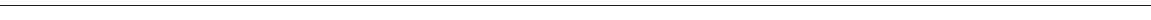
FIGURE 5 | neuron-specific NF-L mRNA cannot be adequately accounted for by a non-specific effect of brain damage, neuron cell loss, or loss of neurons with neurofibrillary degeneration (McLachlan et al., 1988; Lukiw et al., 2018). The AD group ( N = 3) had a mean age of 76.1 ± 11.4 years and a mean post mortem (PMI; death to brain-freezing period) of ∼ 3.4h and the control group ( N = 3) had a mean age of 75.5 ± 12.7 years and a mean PMI of ∼ 3.5h; all brain samples were from female donors; there was no significant difference in the mean age, gender, PMI, or yield of total RNA between the AD and control groups. Total RNA was extracted and probed for α -tubulin, VAMP, synaptophysin, synapsin, the neurofilament light and medium neurofilaments, and quantified based on unchanging β -actin control levels in the same sample using methods explained in detail in previously published study from our laboratories (McLachlan et al., 1988; Lukiw et al., 2008, 2018); deficits in synapse-relevant gene expression were consistently found to be NF-L < synapsin < synaptophysin < VAMP; these observations are also consistent with synaptic signaling deficits in AD brain compared to three unchanging biomarkers: β -actin, α -tubulin, and the NF-M chain protein; * p < 0.05; ** p < 0.01 (ANOVA). (B) Down-regulation of mRNAs coding for vesicle-associated membrane protein (VAMP), synaptophysin (SYP), synapsin, and NF-L in Alzheimer’s disease vs. age- gender- and post-mortem interval-matched controls using the β -actin cytoskeletal as a “housekeeping gene” and expression control using DNA array analysis (McLachlan et al., 1988; Lukiw et al., 2008, 2018); the numbers 1–3 along the top represent results from N = 3 control and N = 3 Alzheimer cases; again, all were age-matched from female donors; there was no significant difference in the mean age, PMI, or yield of total RNA between the AD and control groups. (C) Selective deficits for synapse-relevant gene expression were also observed in AD temporal lobe neocortex compared with age- and gender-matched controls using Northern dot blot analysis. Deficits in gene expression for synaptic components in control ( N = 9) vs. AD ( N = 9) female superior temporal lobe (Brodmann A22) neocortices using quantitative Northern dot blots for signal quantitation; the PMI for all tissues was ∼ 4h or less; a 288-gene matrix was generated using a Biomek 2000 robot (Beckman-Coulter Life Sciences, Indianapolis, IN, United States) at a Northern dot blot density of about 30 genes/cm 2 ; in (C) , each vertical column represents the Northern dot blot signature of one control or one AD brain, and each horizontal row represents the hybridization signals from one particular synaptic-relevant probe; signal intensity of each dot in the dot blot is proportional to the abundance of that specific mRNA in the sample; note significant deficits in signal strength (signal intensity of the dot blot) for NF-L, synapsin, synaptophysin, and vesicle-associated membrane protein (VAMP) and negligible changes between control and AD for α -tubulin, NF-M, the amyloid precursor protein (APP), tau, the 43 kDa growth associated protein GAP43 (neuromodulin), the cytoskeletal protein β -actin, glial fibrillary acidic protein (GFAP), and the large ribosomal subunit 28S RNA. In these DNA array studies, the control group ( N = 9) had a mean age of 77.5 ± 13.5 years, and the AD group ( N = 9) had a mean age of 78.5 ± 11.8 years; all brain samples were from female donors; again, there was no significant difference in the mean age, gender, PMI, or yield of total RNA between the AD and control groups. Experimental values in all of the Figures are expressed as mean ± standard deviation of that mean. This figure represents updated and additional new information for NF-L gene expression data adapted from earlier studies on specific cytoskeletal